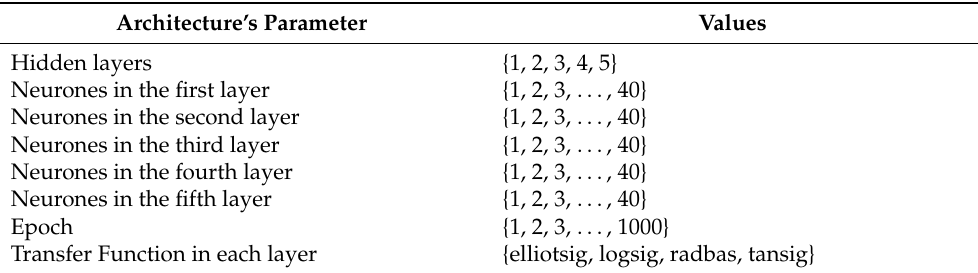
Figure 4. The process of virtual modeling for a spark ignition engine through ANN + GA. Table 2. ANN architecture properties